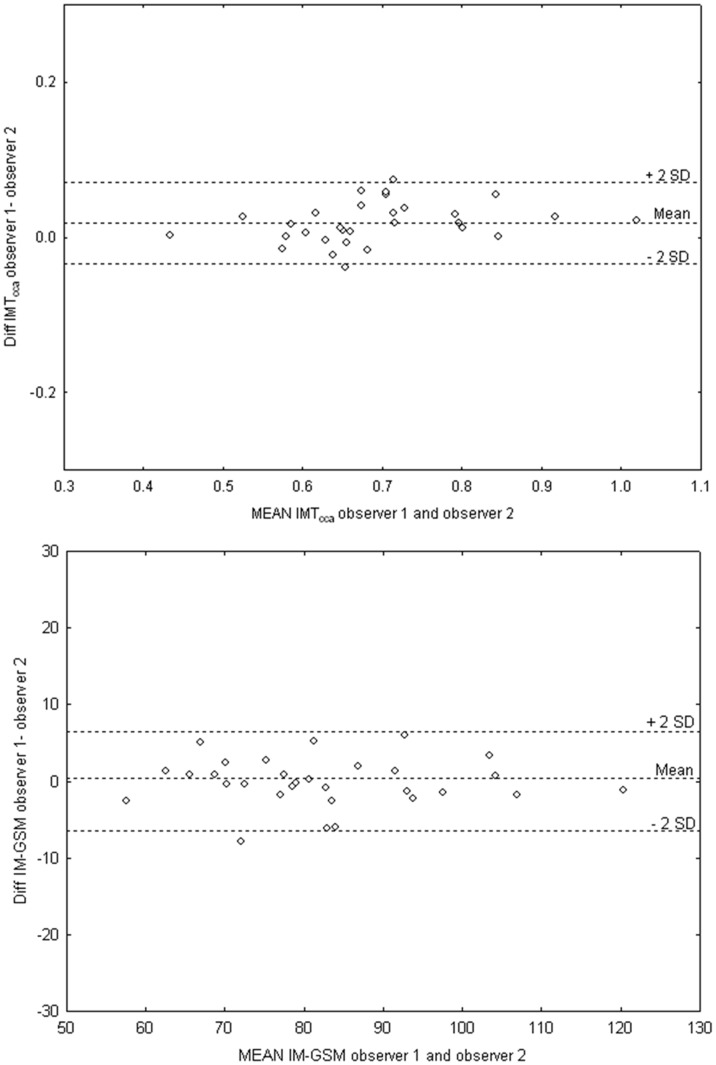
Bland-Altman plots of inter-observer variability.Measurements of the common carotid artery intima media thickness (IMTcca) are illustrated in the upper panel, and of the grayscale median (IM-GSM) in the lower panel.